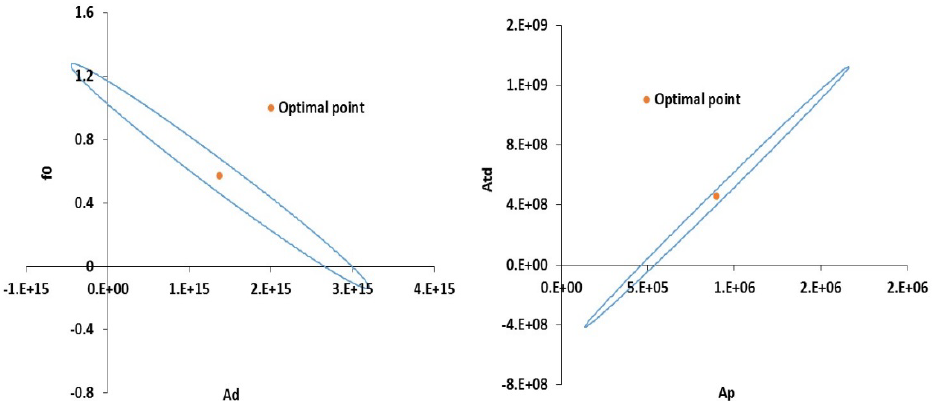
Figure 6. Confidence ellipsoids for A d – f 0 and A p – A t . Table 4. Original and estimated value of the kinetic rate parameters (second iteration) for the free radical polymerization of MMA.